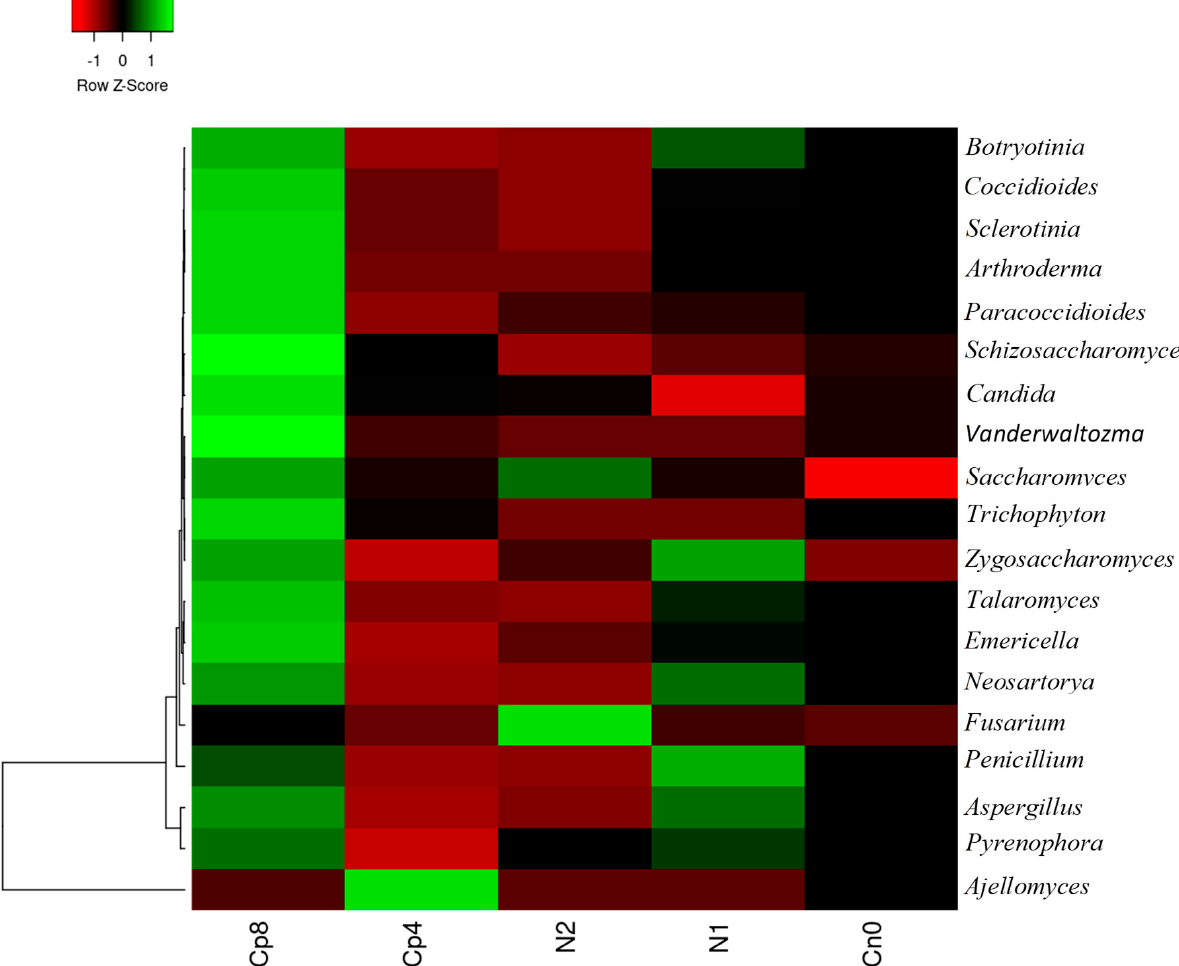
Figure 2. Relative abundance of fungal community at genus level present in the maize rhizosphere under fertilization treatments and the control samples. Cp8 (8 tons/ha compost), Cp4 (4 tons/ha compost manure), N2 (120 kg/ha NPK), N1 (60 kg/ha NPK), and Cn0 (control).